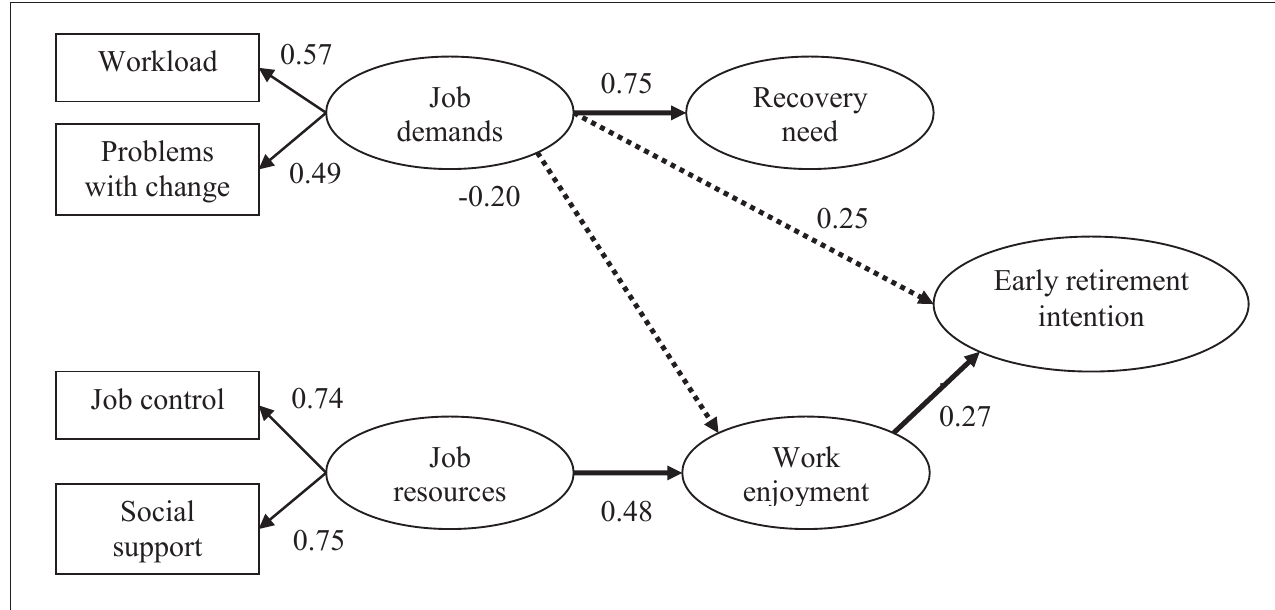
FIGURE 2: The final model (standardised path coefficients). Solid lines refer to predicted relationships. Dashed lines refer to non-predicted relationships.